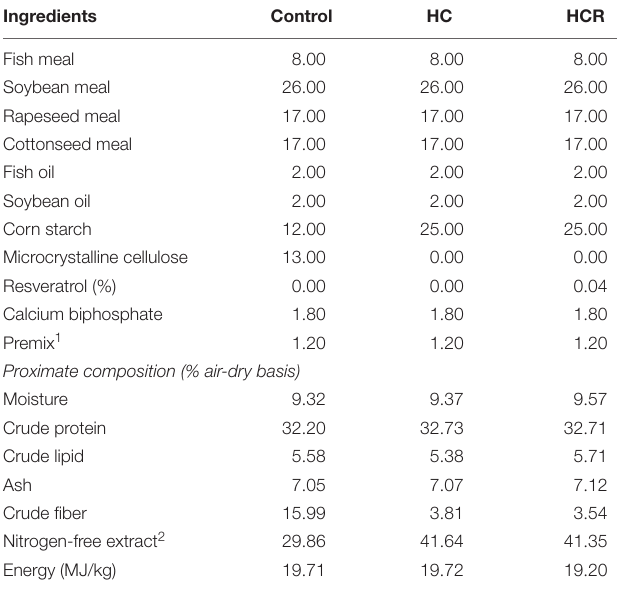
TABLE 1 | Formulation and proximate composition of the experimental